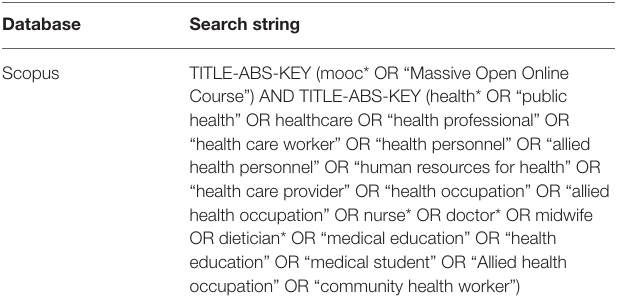
TABLE 1 | Search string for Scopus.